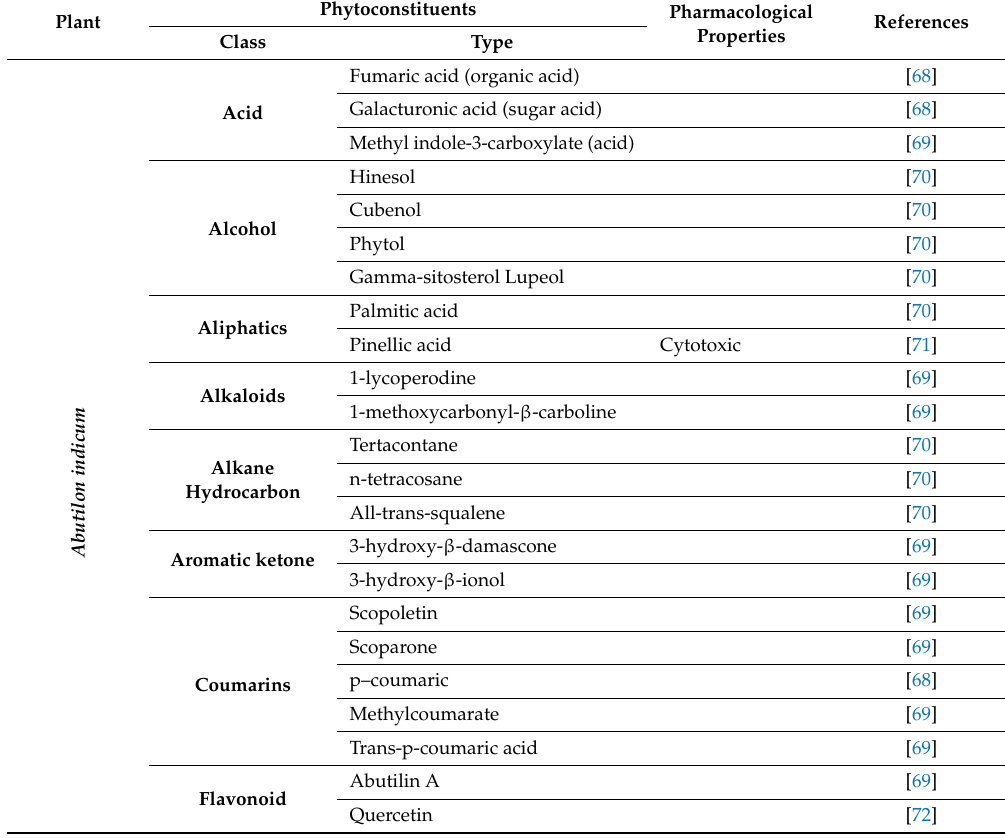
Table 1. Major phytoconstituents identified from Abutilon indicum , Hibiscus sabdariffa , Sida acuta and Sida rhombifolia .